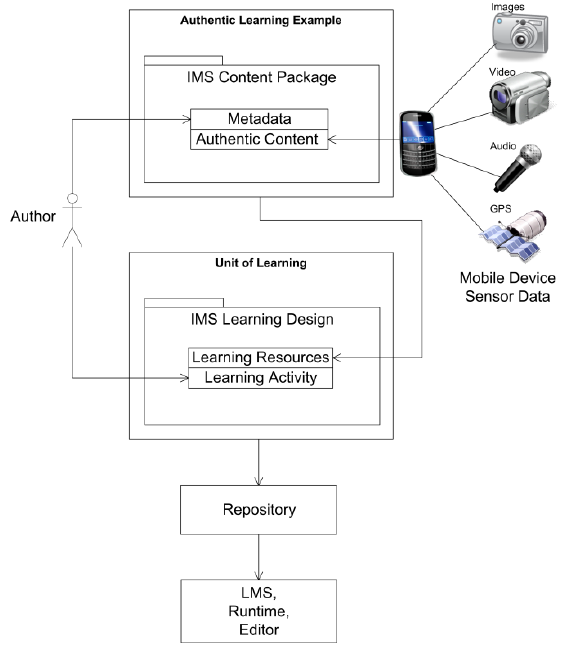
Figure 1 . Conceptual design of the mobile authentic authoring